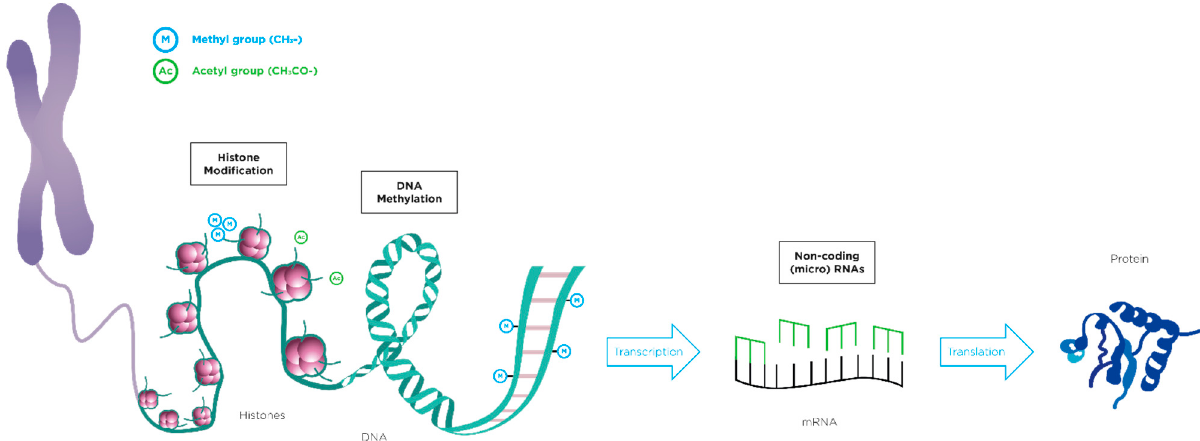
Figure 1. Epigenetics modifications: (1) classical way with an upstream control of gene transcription through methylation; (2) alternative post-transcriptional pathway which involves microRNAs.